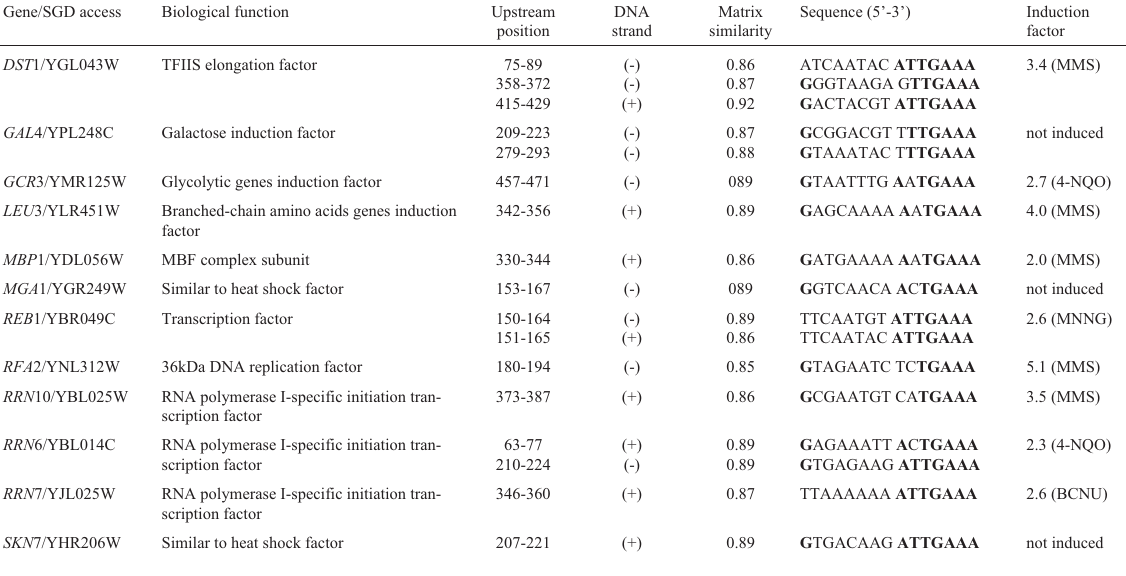
Table 3 - Yeast transcription factor-encoding genes identified by MatInspector for the presence of a DRE-matrix motif in their -500 bp promoter sequence a